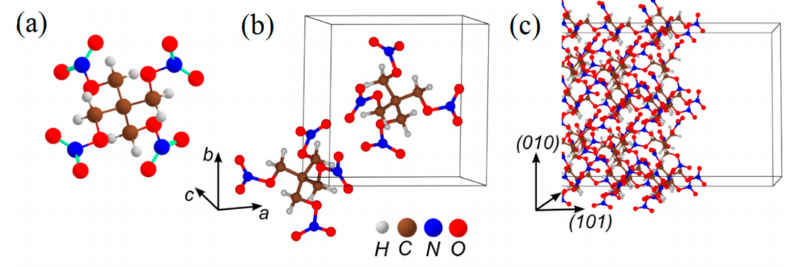
Figure 2. The structure of ( a ) the PETN molecule; ( b ) the PETN crystal; and ( c ) the model supercell representing the (101) PETN surface.